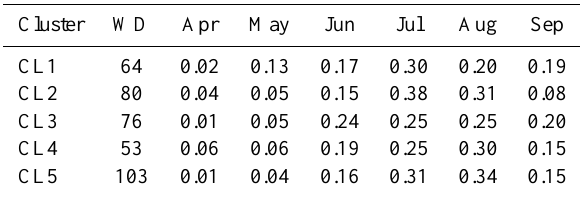
Table 5. Relative frequency of every CL by month. Table 6. Monthly frequency of WD according to the CA